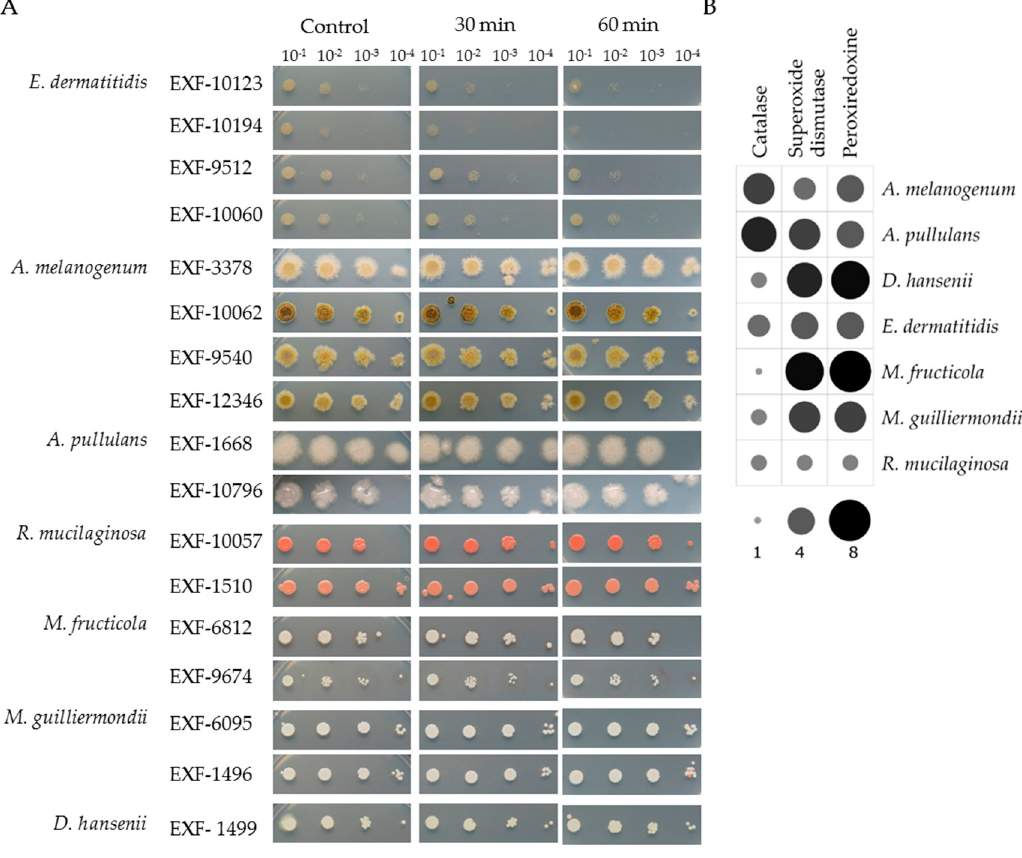
Figure 2. ( A ). Spot assays for the selected yeast strains under oxidative stress due to 30 min and 60 min exposure to 20 mM H 2 O 2 compared to the control. ( B ). Predicted catalases, superoxide dismutases and peroxiredoxins in the representative proteomes. The size and color intensity of dots corresponds to the number of homologues.